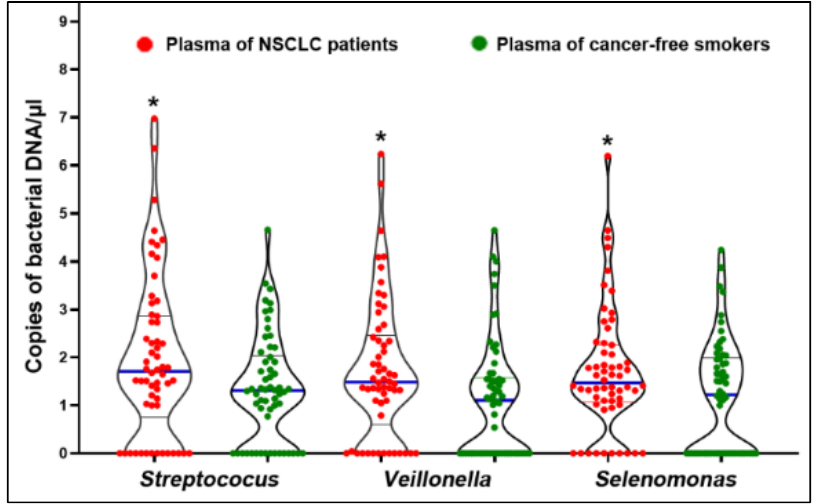
Figure 3. Three bacterial genera have a higher level of DNA abundances in plasma of lung cancer patients compared with controls. The solid blue line shows median. The black line shows quartiles of DNA copies of each bacterium. *, p < 0.05. DNA copy numbers of the three bacterial genera ( Selenomonas , Streptococus , and Veil- lonella ) in plasma were significantly correlated with those in the corresponding tissue specimens (Figure 4) (All p < 0.05; Spearman’s rank correlation). Therefore, Selenomonas , Streptococus , and Veillonella abundances displayed comparable levels in plasma samples vs. The matching primary cancer